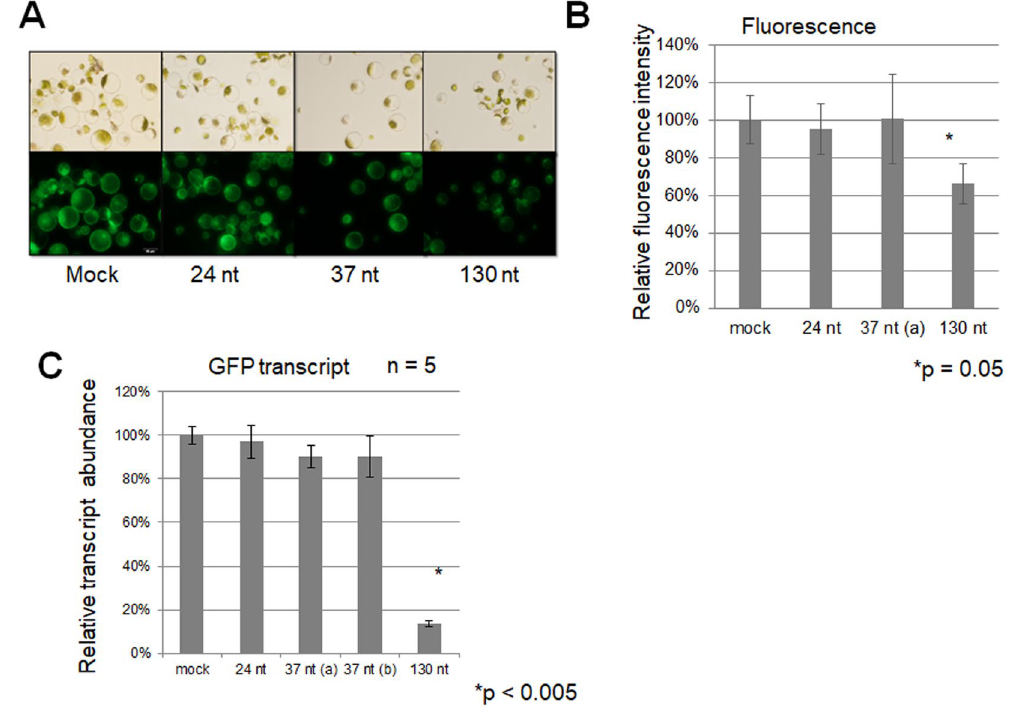
Figure 3. RNAi (gene silencing) for the exogenous GFP gene was successfully induced by direct transfer of long dsRNAs of about 130 nt into protoplasts. Approximately 3 µ g of dsRNA was transfected into 0.1 mL of protoplasts (10 6 to 10 7 cells/mL) prepared from 2-week-old Arabidopsis seedlings over-expressing the GFP gene. The efficacies of various-sized dsRNAs for inducing RNAi were evaluated by ( A , B ) observing green fluorescence by microscopy and ( C ) analysing the relative abundance of GFP transcripts by qRT-PCR. ( A ) Bright-field (upper panels) and fluorescence (lower panels) micrographs of protoplasts transfected without (mock) or with 3 µ g of various-sized dsRNAs against GFP (RNAi) were examined, and the fluorescence was quantified. Fluorescence micrographs were photographed 2 days after transfection. All images were captured for the same exposure period. ( B ) Fluorescence intensities of dsRNA-transfected protoplasts relative to that of mock-transfected protoplasts (100%) were calculated using ImageJ software. Error bars indicate the standard errors of three replicates, and the p-value was determined using the Student’s t -test. ( C ) The relative abundance of GFP transcripts in dsRNA-transfected protoplasts compared to mock-transfected protoplasts (100%) was determined by qRT-PCR. Protoplasts in 100 µ L (10 6 to 10 7 cells/mL) were transfected without (mock) or with 3 µ g of various-sized dsRNAs against the exogenous GFP gene (RNAi). Two 37-nt dsRNAs (a and b) with a different nucleotide at each end were used. Total RNAs were extracted from protoplasts 2 days after transfection. The efficacies of dsRNAs for inducing RNAi were analysed by qRT-PCR for the relative abundance of GFP transcripts normalized to ACT2 transcripts (house-keeping gene). Error bars indicate the standard errors of five biological replicates, and p-values were determined using the Student’s t -test. Asterisks ( * ) in ( B , C ) indicate significant differences between mock and 130-nt dsRNA